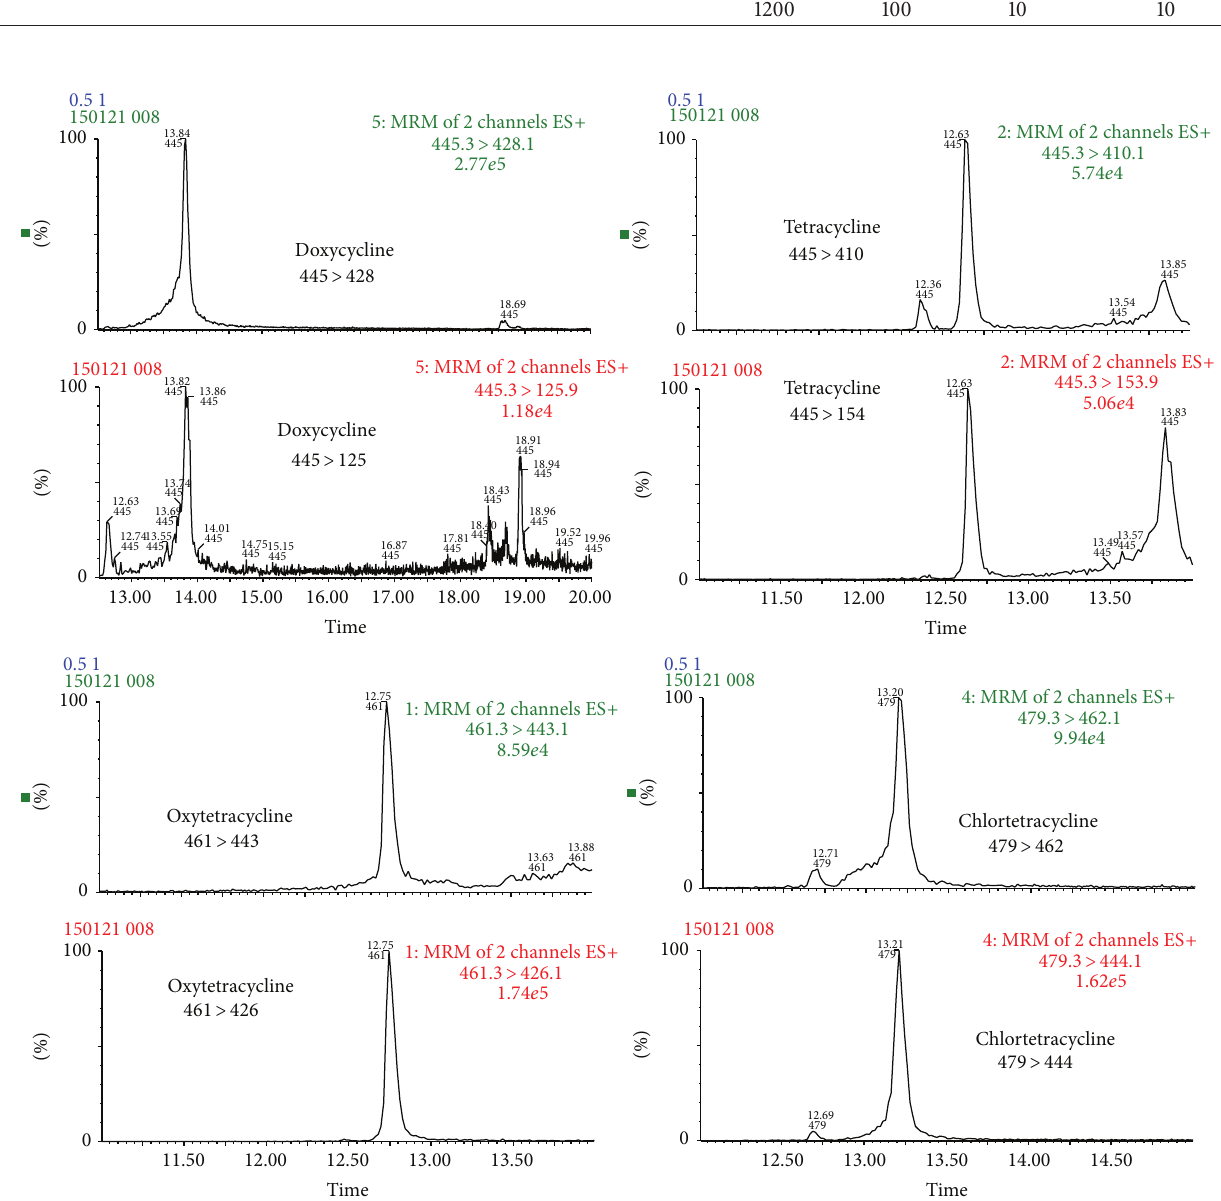
Figure 3: SRM chromatograms of individual tetracyclines in a sample fortified at 400 𝜇